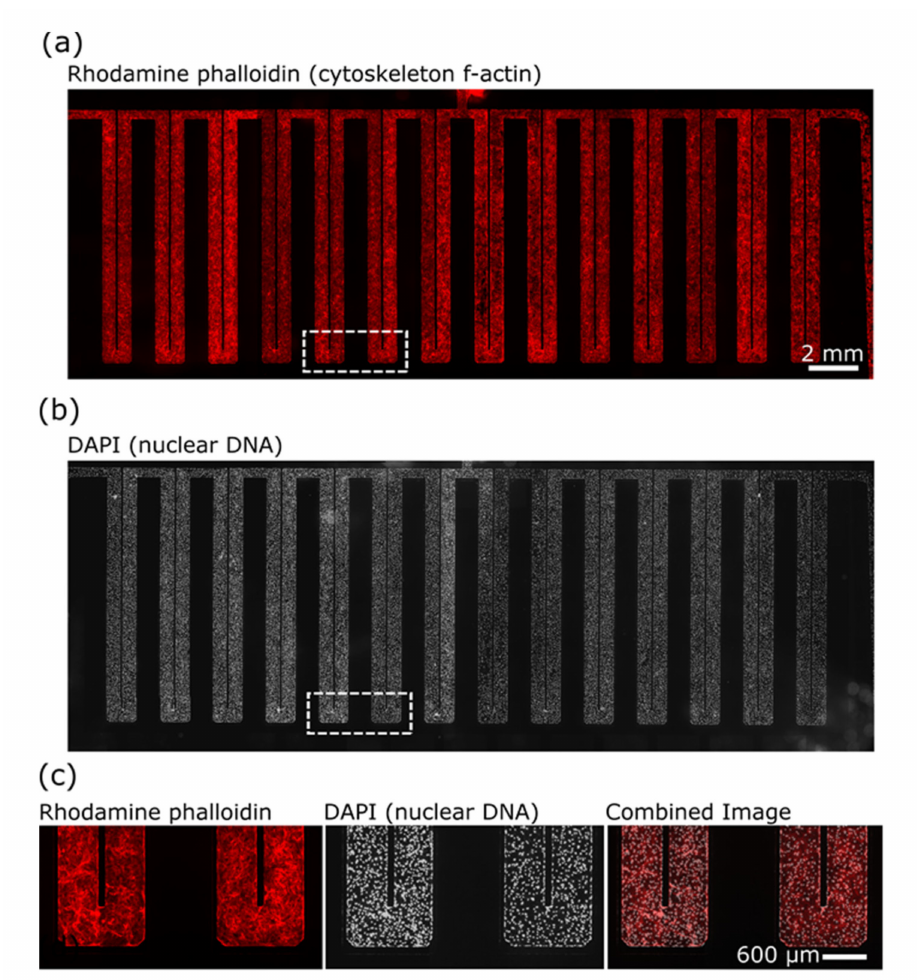
Figure 3. Human microvascular endothelial cells maintained in microfluidics for irradiation and biomarker identification. HMVEC-L cells were cultured with perfusion (0.25 to 0.5 µ L/min) to confluence for 6–8 days to produce vascular lumens on a chip for irradiation and mass spectrometric analysis of perfusates. Composite images of the f-actin cytoskeleton, cellular nuclei, and merged images are shown here at 3 days in vitro. ( a ) Rhodamine-phalloidin-labeled f-actin cytoskeleton in HMVEC-L. ( b ) Cellular nuclei were labeled with DAPI. ( c ) Magnified end regions of microfluidic U-turn channels are identified by the dashed region of